Question: Looking at the figure, what chart type is it?
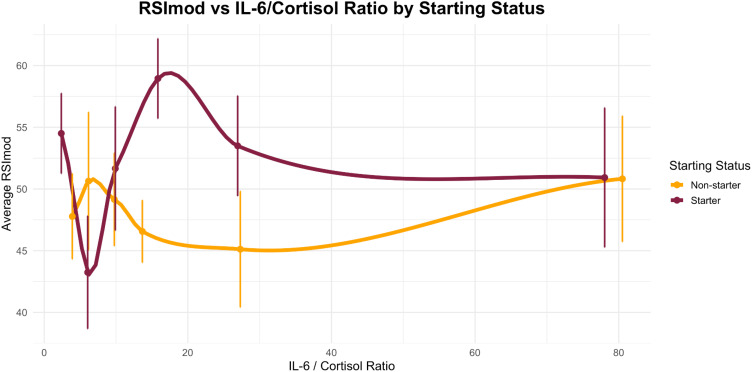
Answer: line